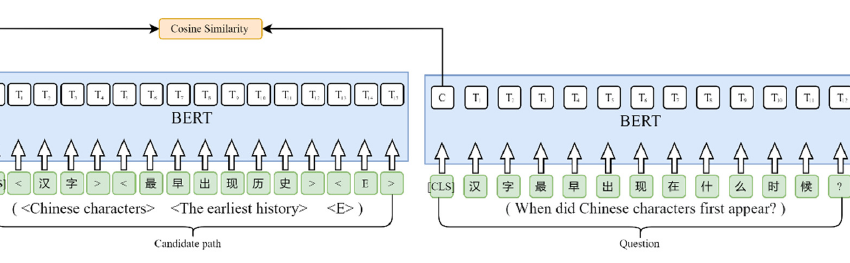
Figure 3. The architecture of representation-based BERT model. Algorithm 1 : The calculation method of interactive textual